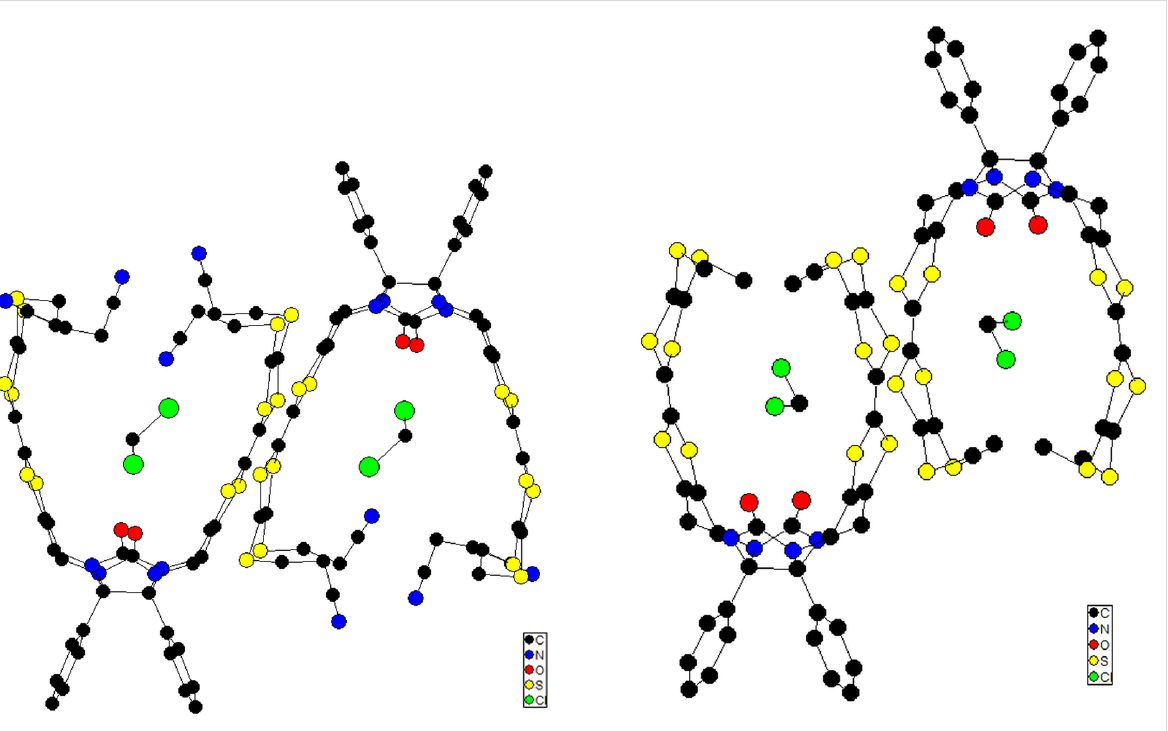
Figure 8: Molecular packing diagram of clips 2 (left) and 3 (right) obtained from X-ray analysis. A molecule of CH 2 Cl 2 is included inside the cavity of each clip. Hydrogen atoms are omitted for clarity.